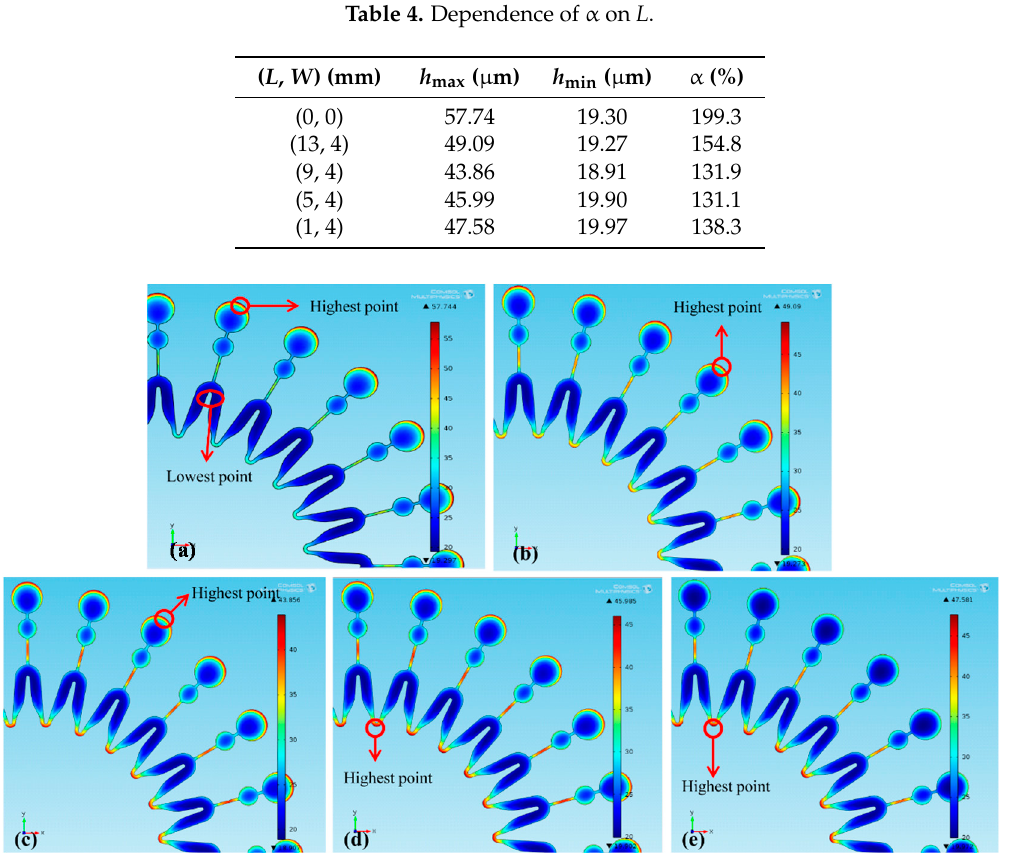
Figure 3. Thickness distribution of the mold: ( a ) without a second cathode; ( b ) L = 13 mm; ( c ) L = 9 mm; ( d ) L = 5 mm; ( e ) L = 1 mm.